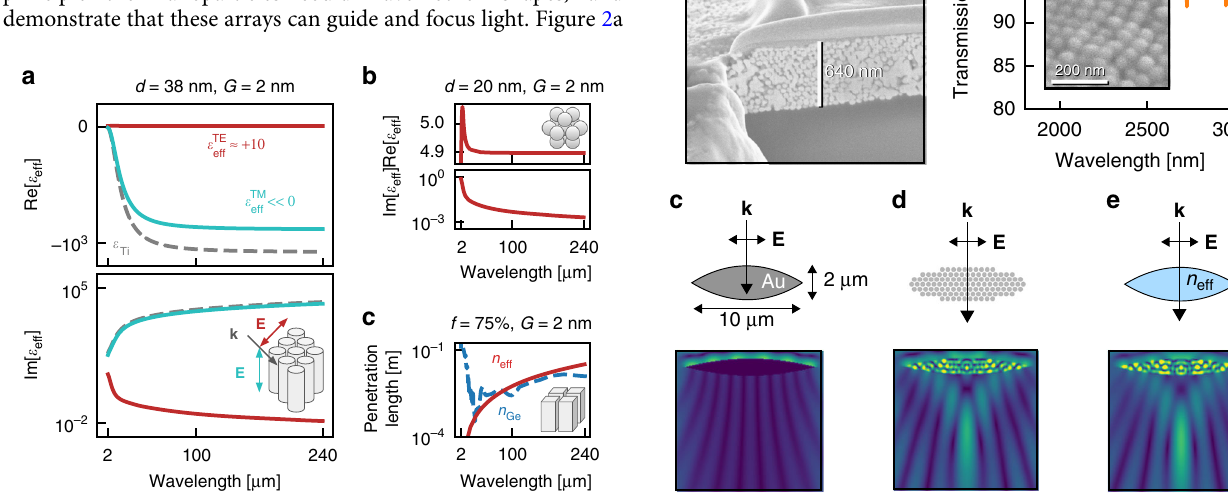
Fig. 2 Effective permittivity of metallic nanoparticle arrays. a The effective permittivity of an array of titanium nanocylinders (with diameter d = 38 nm and surface-to-surface separation G = 2 nm) for TE (red curve) and TM (blue curve) polarised light compared to the permittivity of solid titanium (dashed curve). b The effective permittivity of titanium nanospheres, ( d = 20 nm, G = 2 nm) for unpolarised light. c The effective penetration length of the nanoparticle arrays can exceed that of real dielectrics, such as